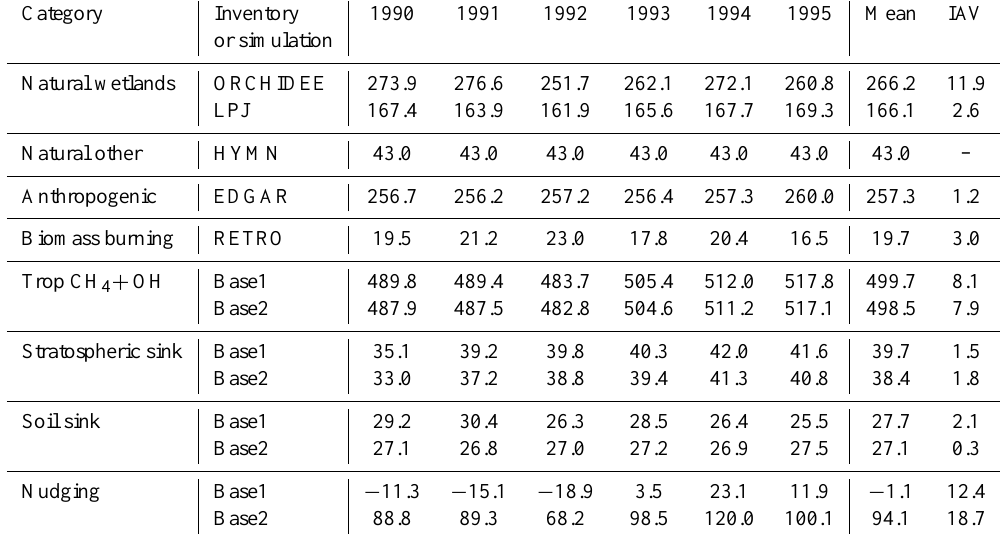
Table 1. Annual mean CH 4 sources and sinks, and their inter-annual variability (IAV). All values are in Tgyr − 1 .